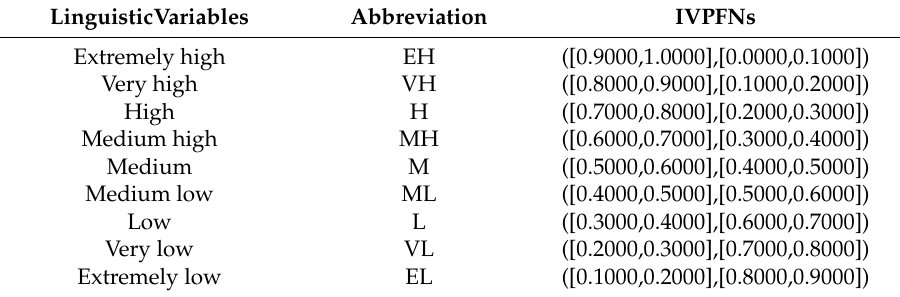
Table 2. Linguistic terms for rating the failure modes